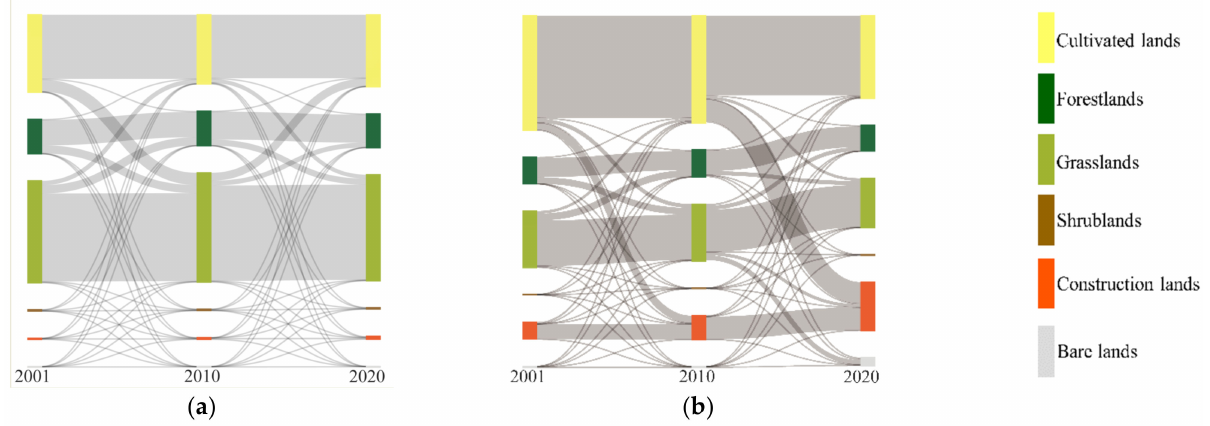
Figure 11. ( a ) Land use change in the regions with strong improvement; ( b ) Land use change in the regions with serious